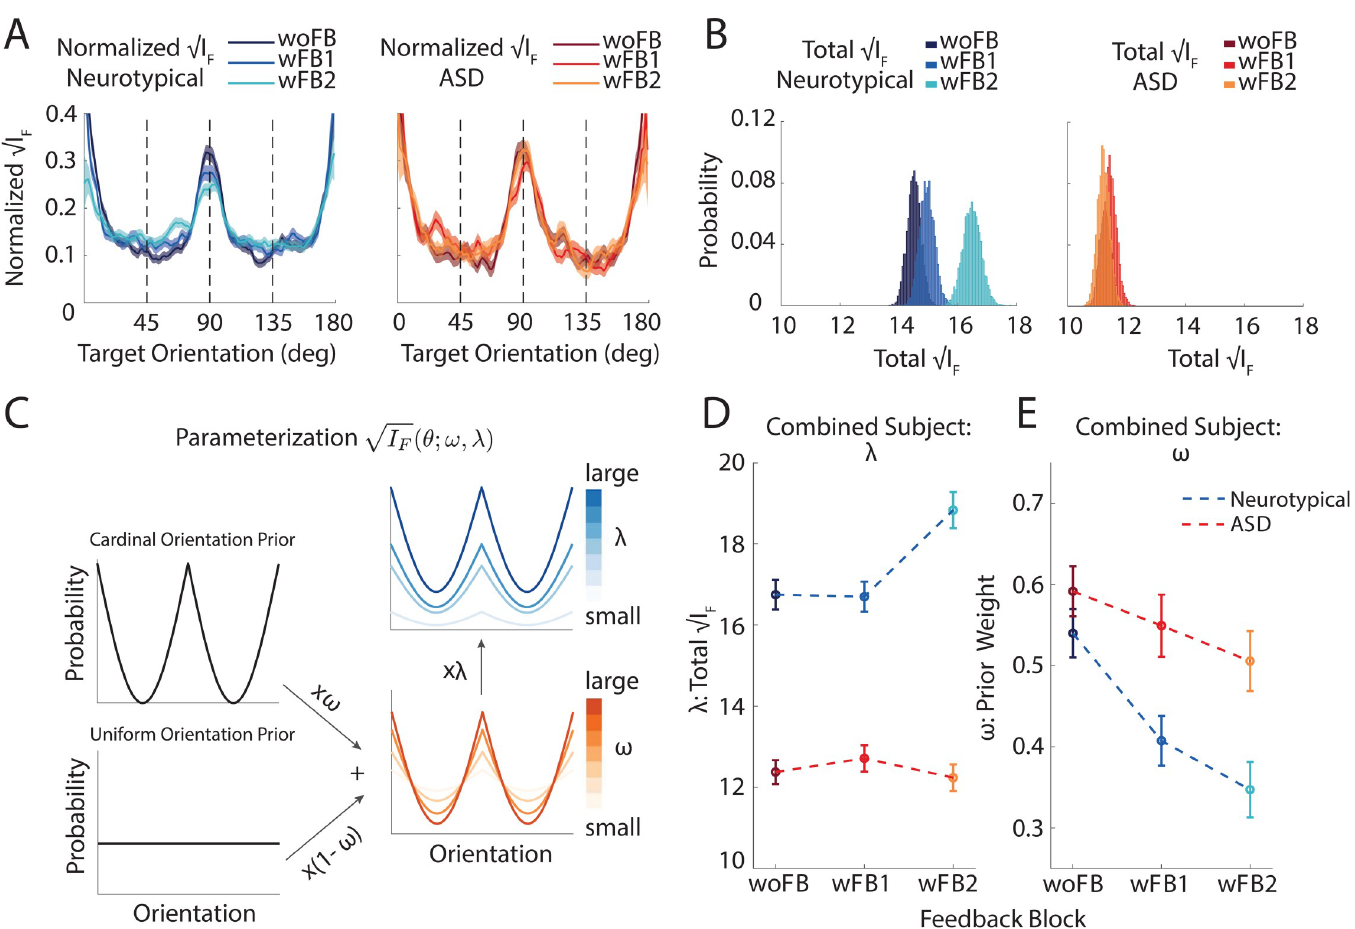
Fig 4. Quantification and parametrization of FI in neurotypical and ASD individuals. (A) FI peaked at cardinal orientations for both neurotypical (blue) and ASD (red) individuals, similar to the natural scene statistics of orientations. Further, visual inspection suggests a flattening of this function with feedback in neurotypical participants (from dark to light blue) but not ASD participants (see panels C and E for quantification). Smoothing using a sliding window of 18˚ has been applied for visualization. ( B) The total amount of FI was larger in neurotypical individuals than ASD at the outset and increased over the course of the experiment in neurotypical (blue color gradient) but not ASD (red color gradient) individuals. ( C) The FI pattern as a function of orientation was quantified by 2 parameters, ω , which mixes a cardinal orientation prior with a uniform distribution as the normalized (square root of) FI, and λ , scaling total FI. ( D) λ and ( E) ω as a function of group (blue = neurotypical control, red = ASD) and block. Error bars are ± SEM across 5,000 bootstrap runs. Raw data and code underlying this figure can be found at S1 Code , and numerical values that make up this figure can be found at S4 Data . ASD, autism spectrum disorder; FI, Fisher information.